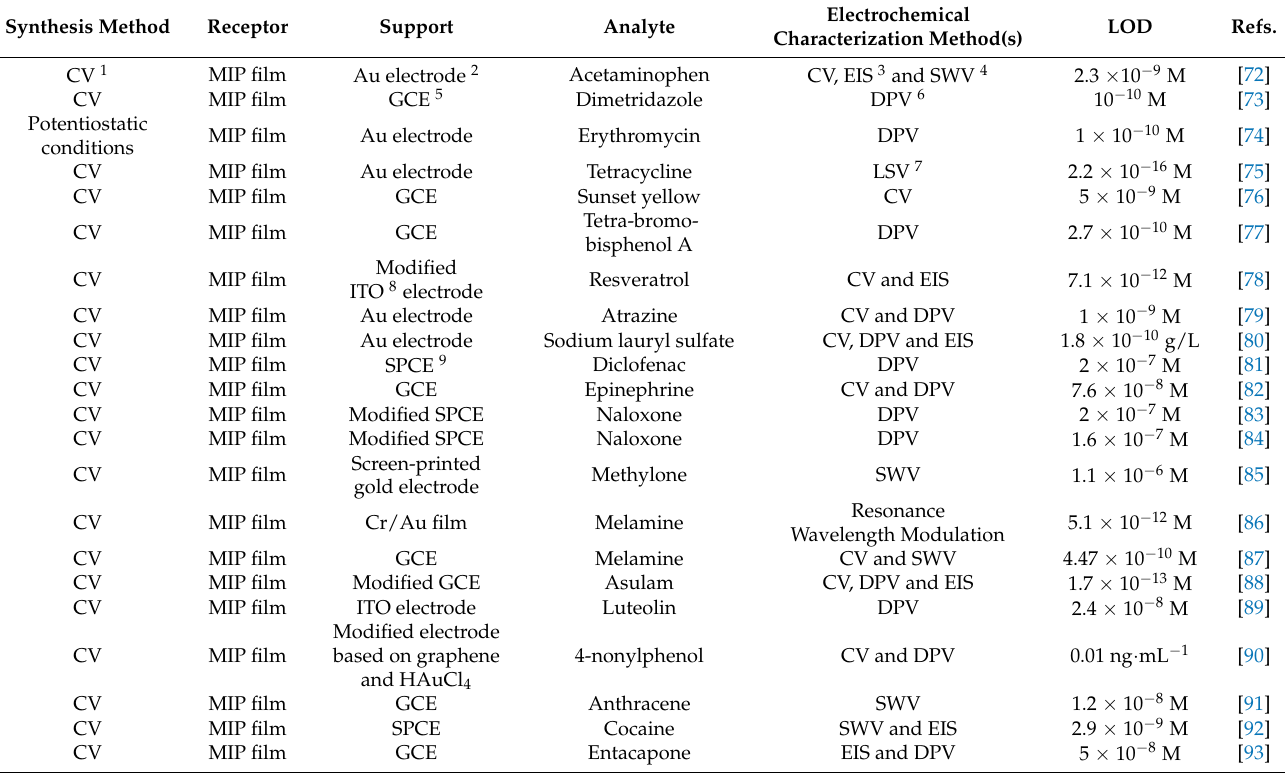
Table 2. MIP-based sensors obtained by